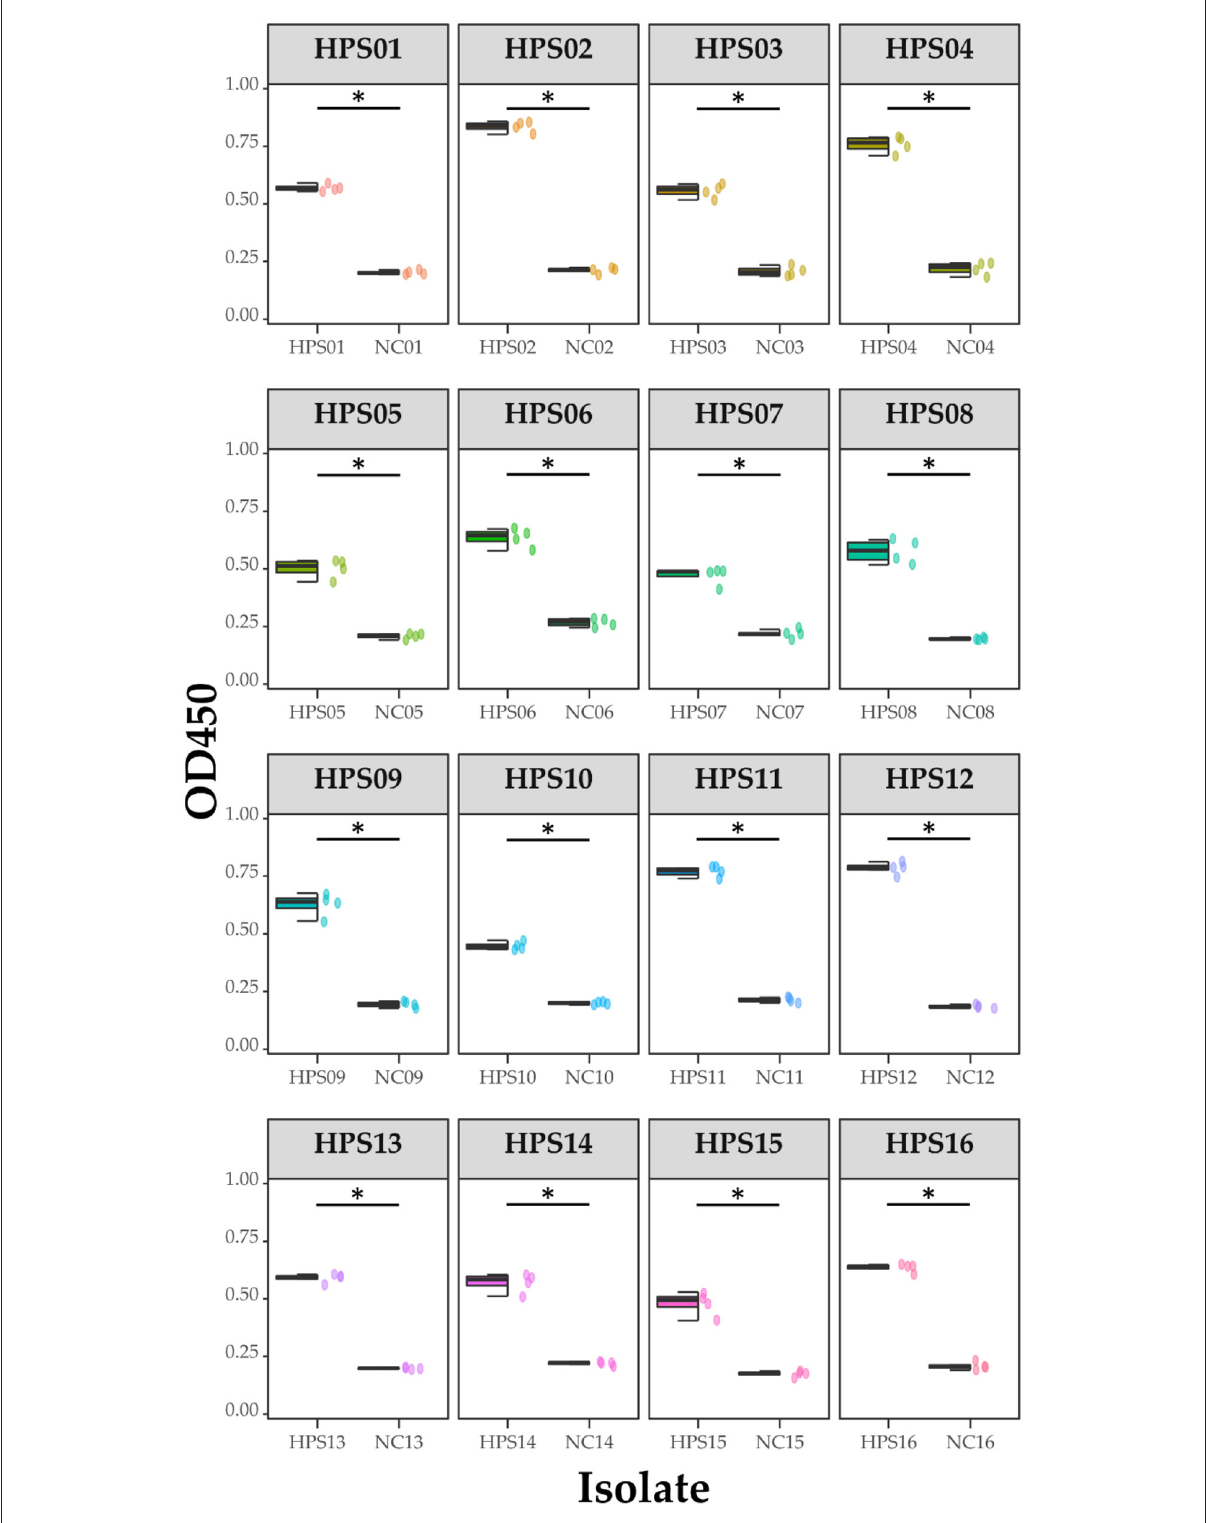
FIGURE12 ELISA results for each isolate. Data are presented using box and scatter plots; NC is negative serum control; * indicates statistically significant